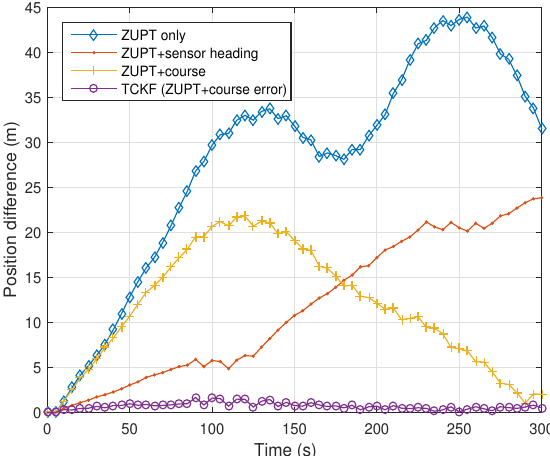
Figure 9. Root-mean-square (RMS) values of position differences between left foot and right foot.